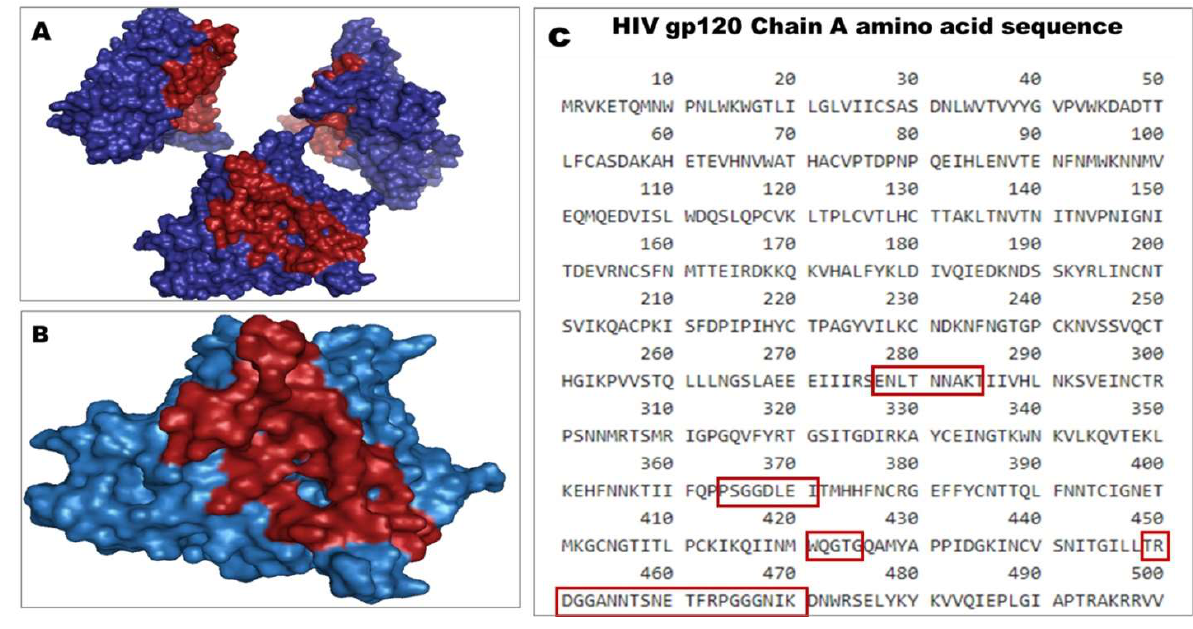
Figure 1. HIV-1 gp120 site of vulnerability for VRC01. ( A ) gp120 trimer (3J70; HXB2) with the site of vulnerability (red), ( B ) gp120 monomer (chain A) with the site of vulnerability (red), and ( C ) gp120 amino acid sequence (chain A) with residues of interaction with VRCO1 (red boxes).